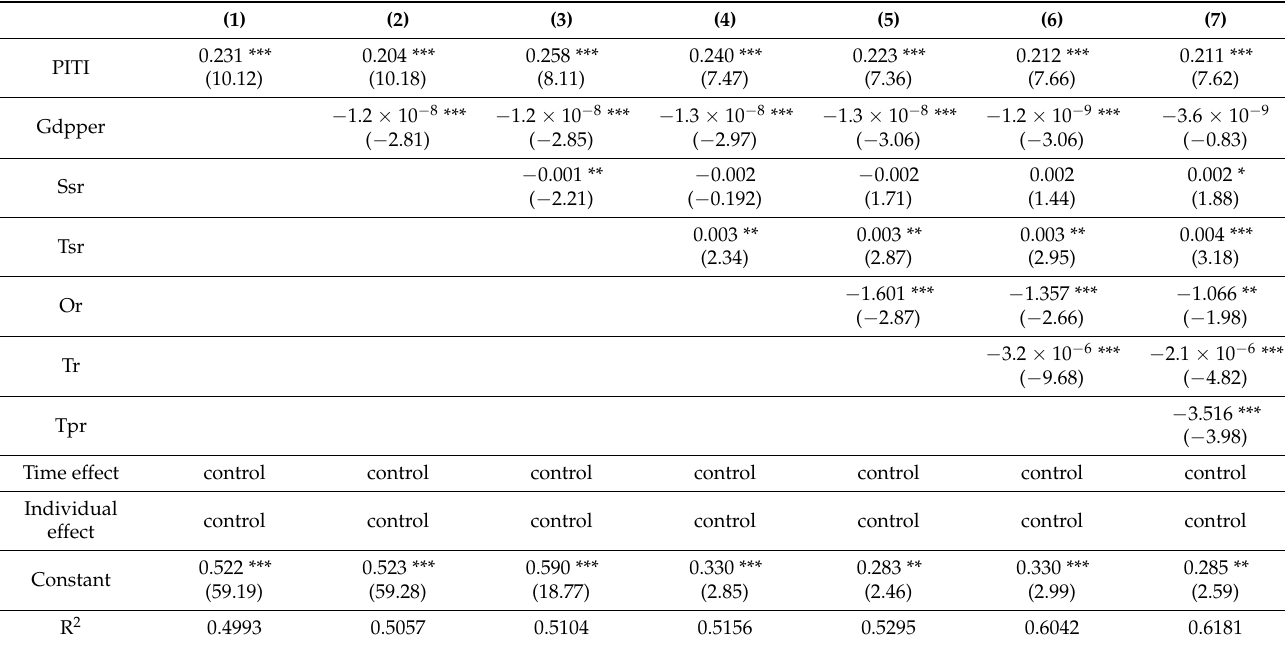
Table 3. Baseline regression